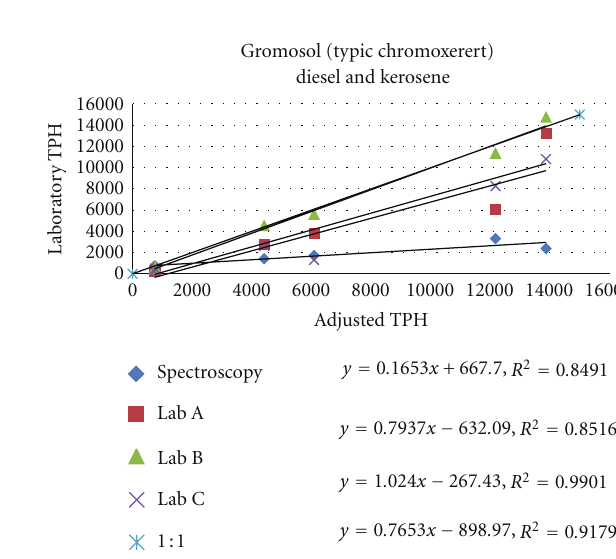
Figure 9: Loess with diesel and kerosene.